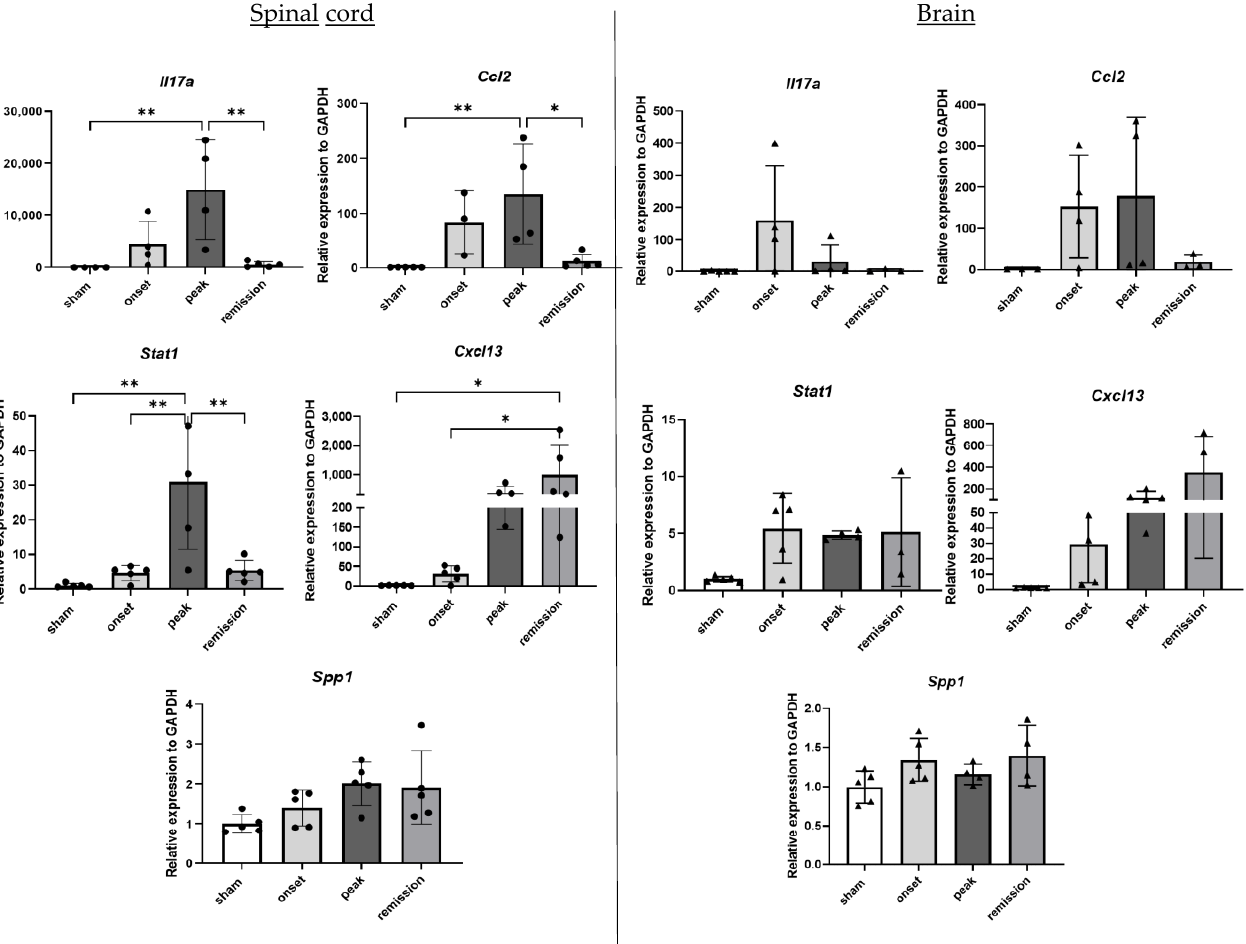
Figure 1. Differential expression of genes representative of inflammation in CNS organs during the different phases of PLP-induced EAE. The levels of mRNA transcripts for the selected genes relative to Gapdh were measured in the spinal cord ( left ) and brain ( right ) samples isolated from adjuvant controls and EAE mice on the onset, peak, and remission phases by RT-qPCR. A number of 3 to 5 mice was used in the experiment. Each symbol represents a sample. * p < 0.05, ** p < 0.01 one-way ANOVA.